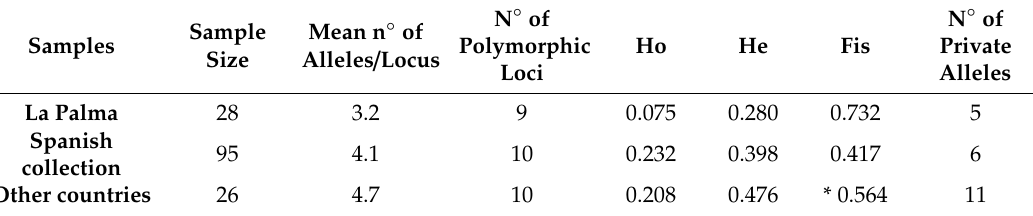
Table 2. Parameters of La Palma, Spain, and other countries (Argentina, Bolivia, Brazil, Canada, France, Italy, South Africa, and Vietnam) peach samples with the analysis with 10 microsatellite loci, including mean of number of alleles per loci, number of polymorphic loci, observed heterozygosity (H o ), expected heterozygosity (H e ), Fst and Wright’s fixation index (Fis) statistic, and number of private alleles.